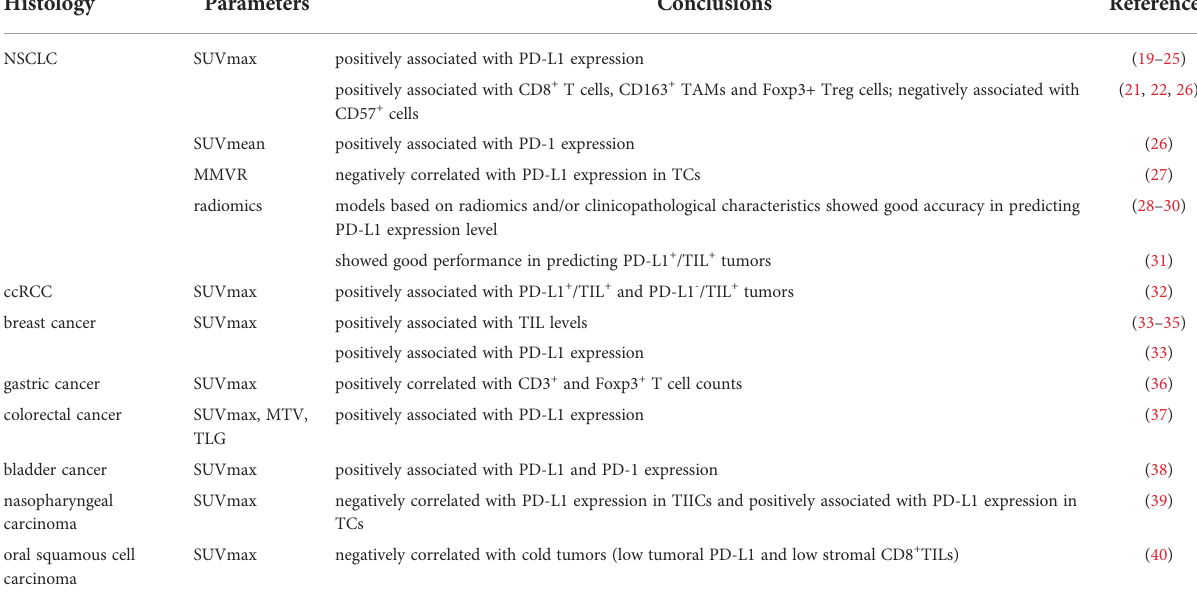
TABLE 1 Tumor microenvironment evaluation by 18 F-FDG PET/CT